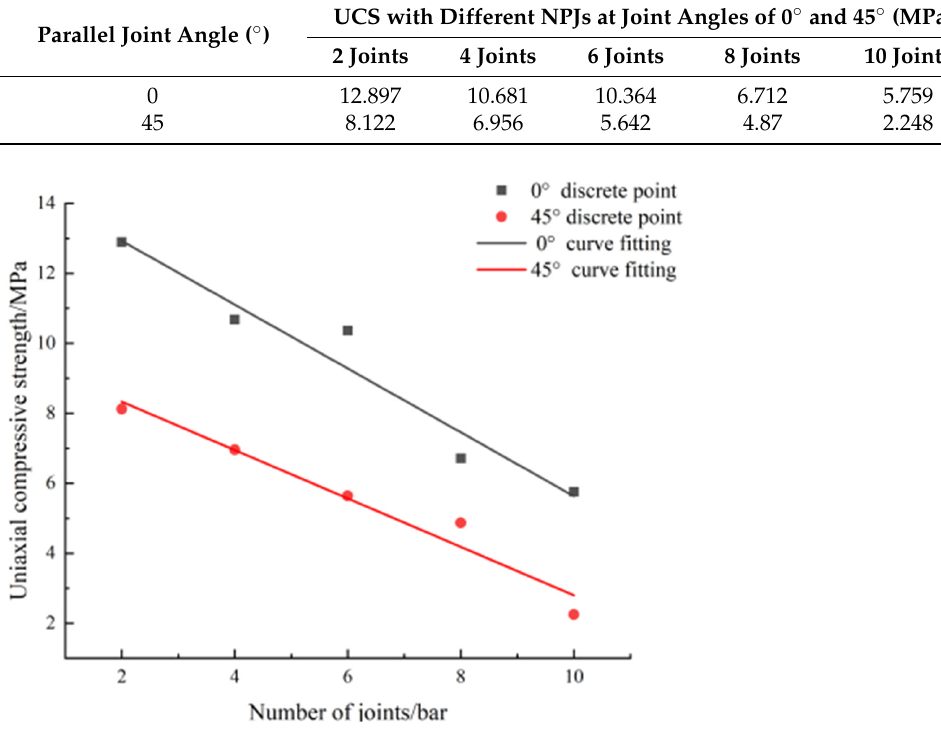
Figure 15. The stress–strain curve with different NPJs when joint angle is 45°. Table 13. UCS with different NPJs at joint angles of 0° and 45°.